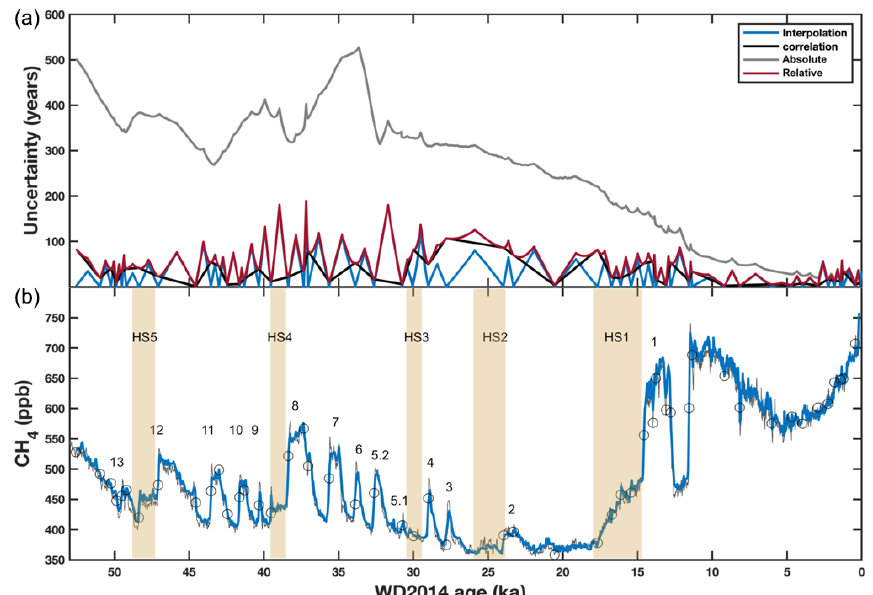
Figure 1. (a) SP19 gas chronology uncertainty ( ± 2 σ ). Black line indicates correlation uncertainty, blue line shows interpolation uncertainty, and red solid line shows total SPC14 uncertainty relative to WD. The red line is a combination in quadrature of the correlation and inter- polation uncertainty. The gray line describes total absolute uncertainty, which incorporates the absolute uncertainty in the WD timescale. Maximum uncertainty of ± 540 years is found around 35ka. (b) SPC19 methane record (blue line), plotted on top of WD CH 4 record (gray) (Rhodes et al., 2015; WAIS Divide Project Members, 2015). Selected tie points are indicated by circles. The gas chronology extends from 116 years to 52482 years BP. D-O events are numbered for orientation; yellow bars indicate Heinrich